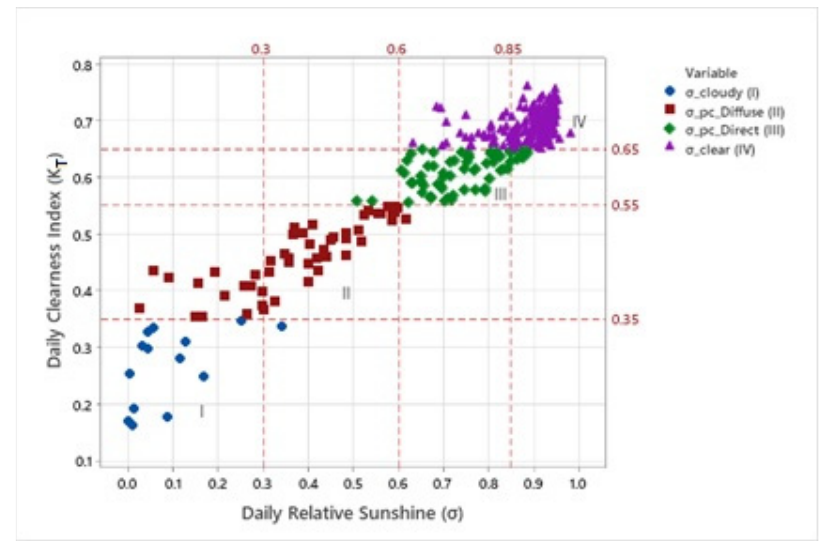
Figure 3. Relationship between the daily clearness index ( K T ) and relative sunshine duration ( σ ) which define the four classes of sky conditions.